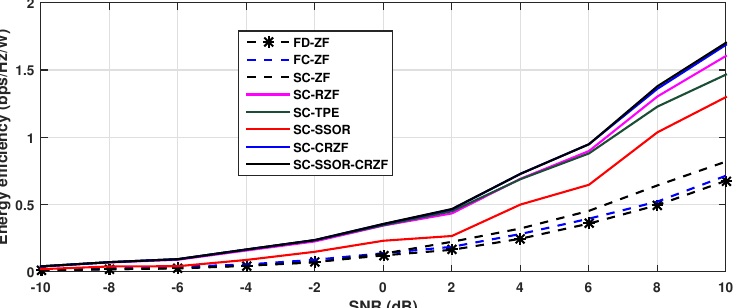
Figure 5. Energy Efficiency Comparison with SNR variation.